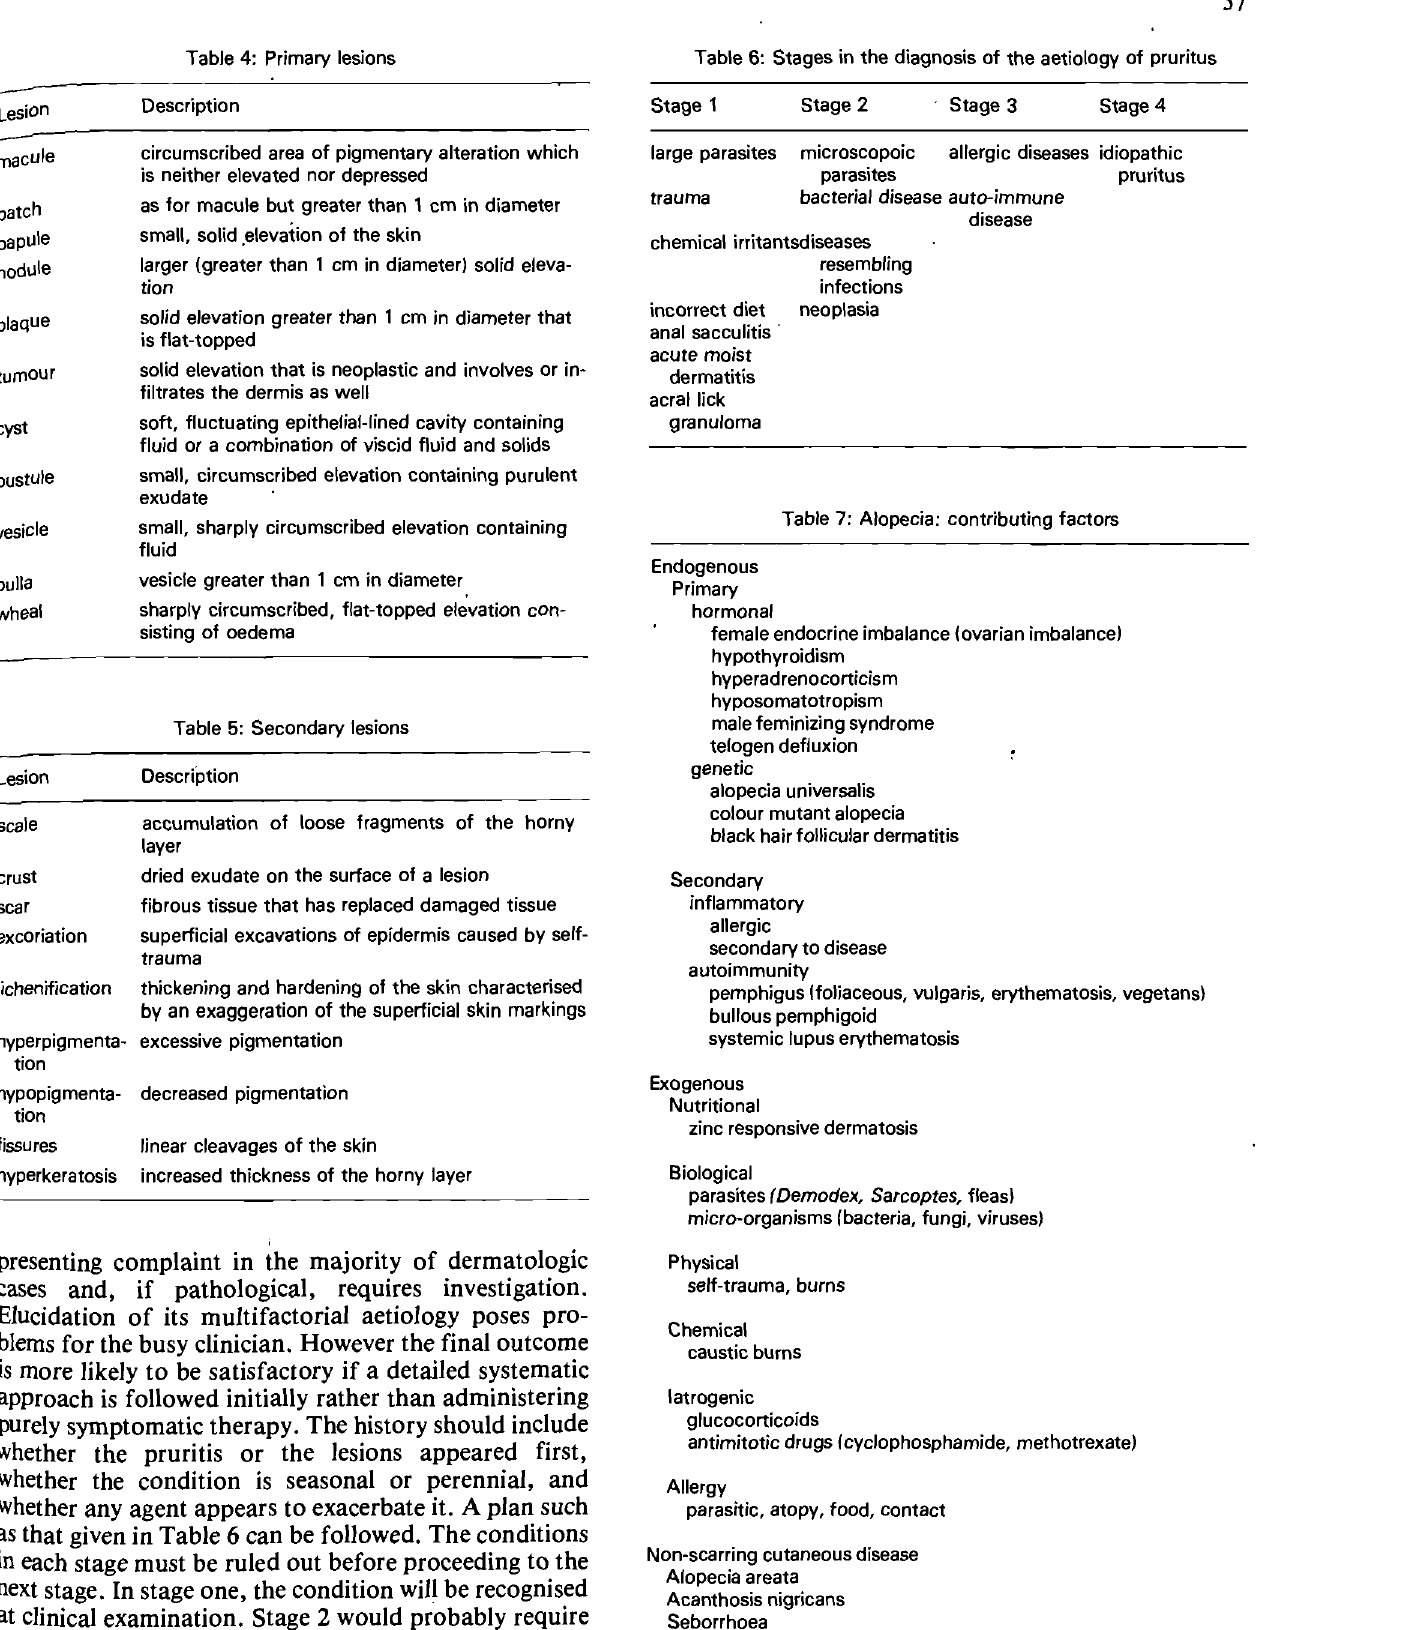
Table 4: Primary lesions